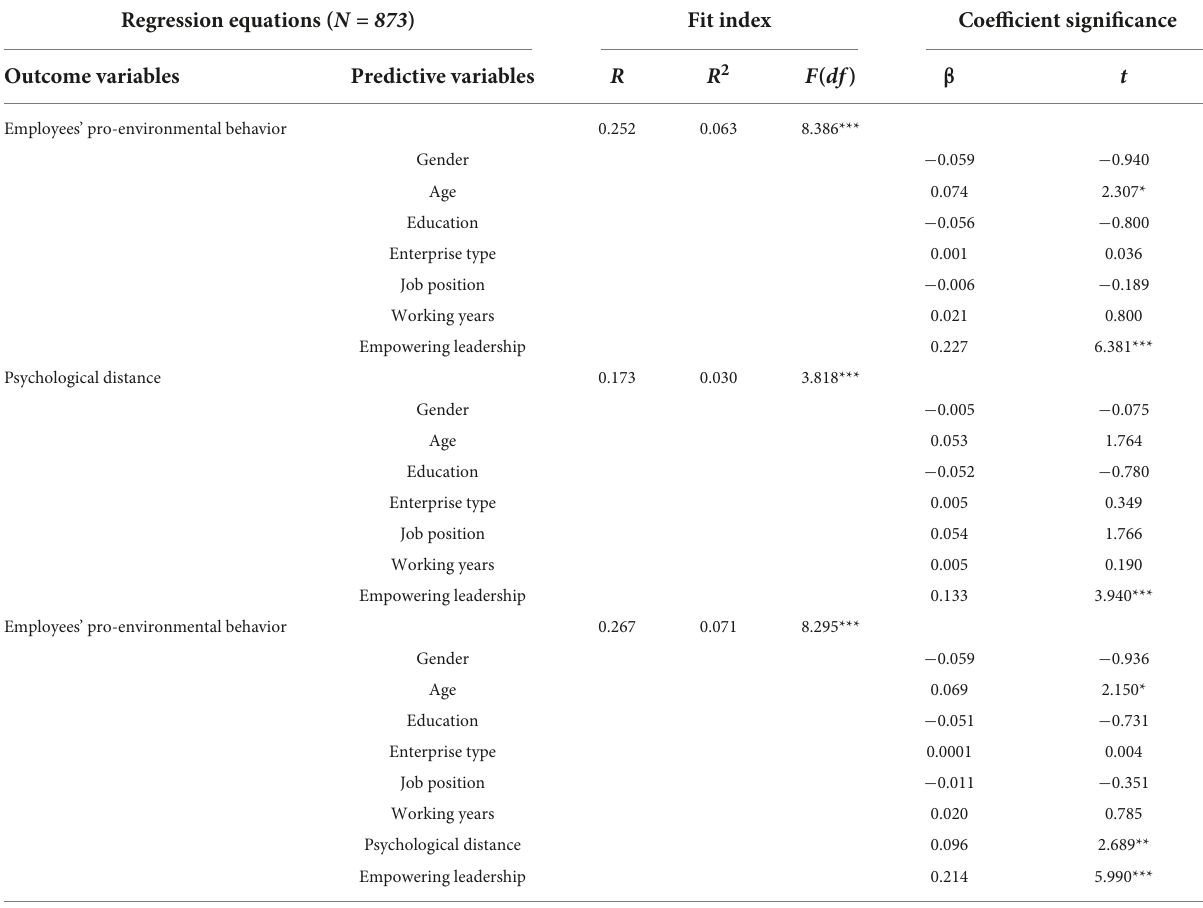
TABLE 4 Mediation model test of psychological